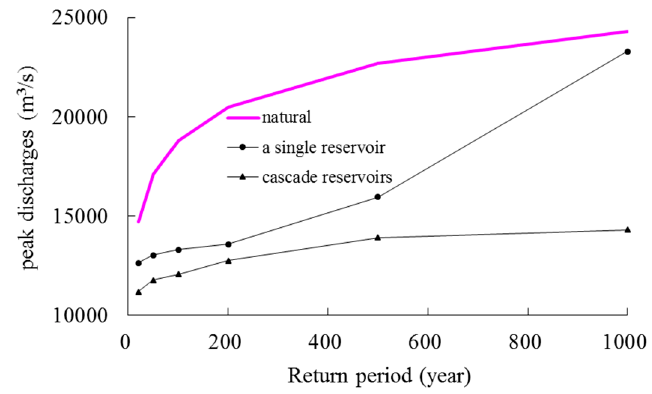
Figure 7. Comparison of design peak discharges at Gaobazhou reservoir site in the natural condition and those of under the influence of upstream reservoirs operation.